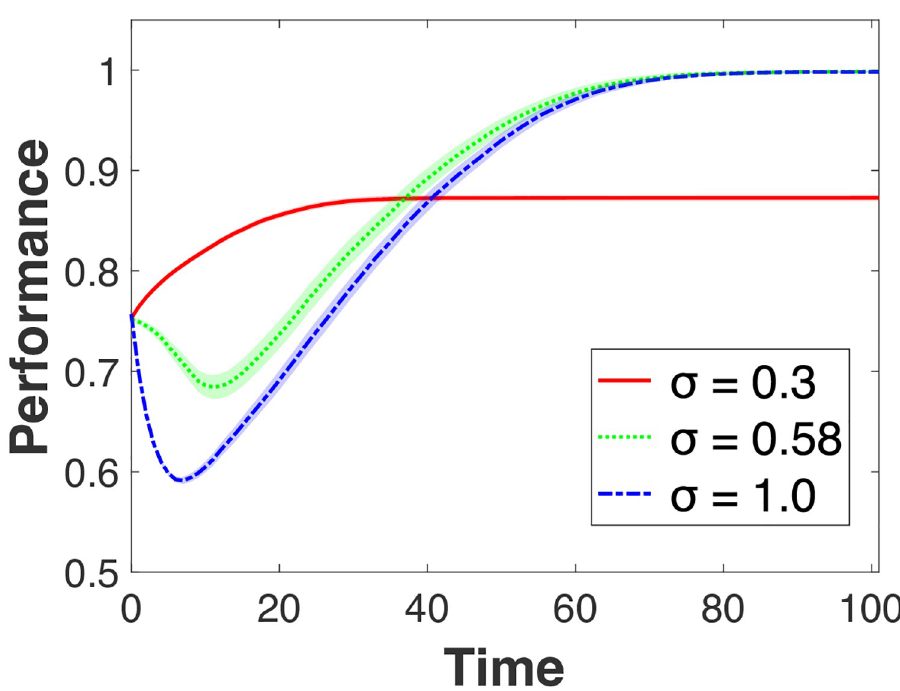
Fig 6. Effects under high initial dispersion of individual knowledge ( μ = 0.5). The shades represent 95% confidence intervals.